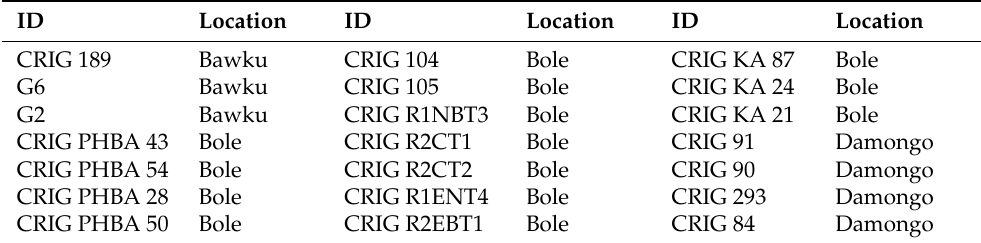
Table 1. List of germplasms collected and their respective regions of